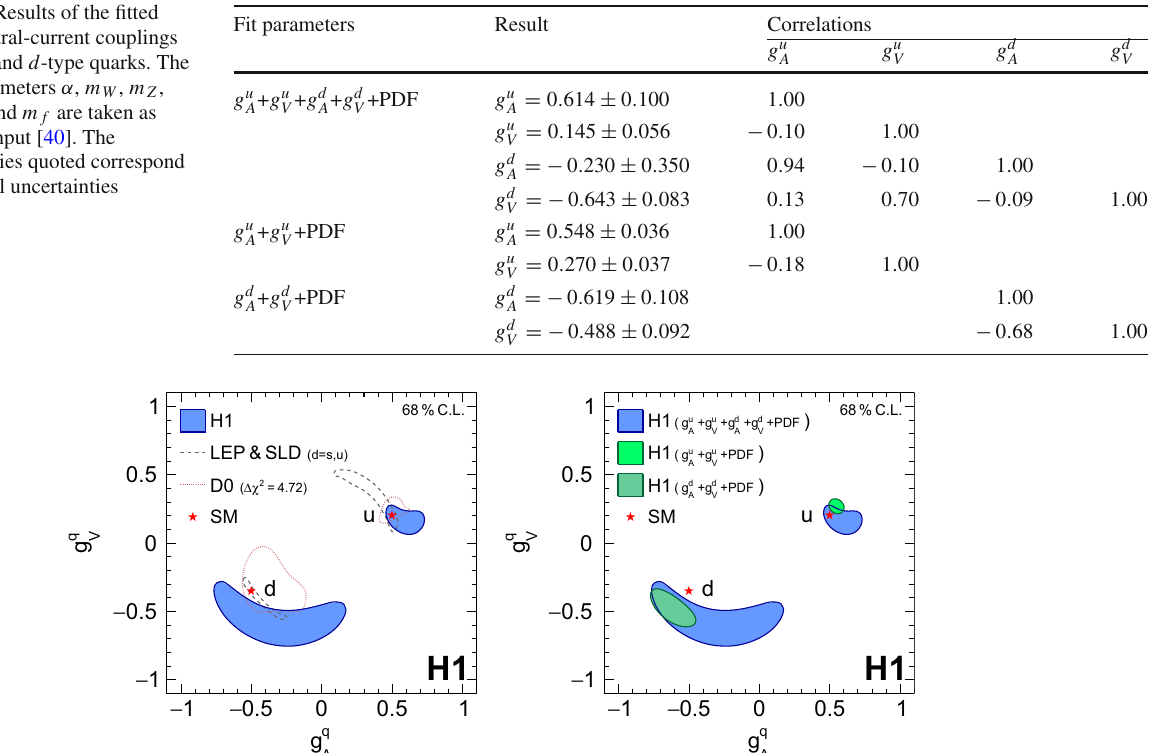
(cid:10)χ 2 = 2 . 3, where at the contour all other fit parameters are minimised. The SM expectation is displayed as a star. The right panel shows a com- parison of results from fits where the couplings of one quark type are fit parameters, and the couplings of the other quark type are fixed, i.e. the g u + g u +PDF and g d + g d +PDF fits A V A V